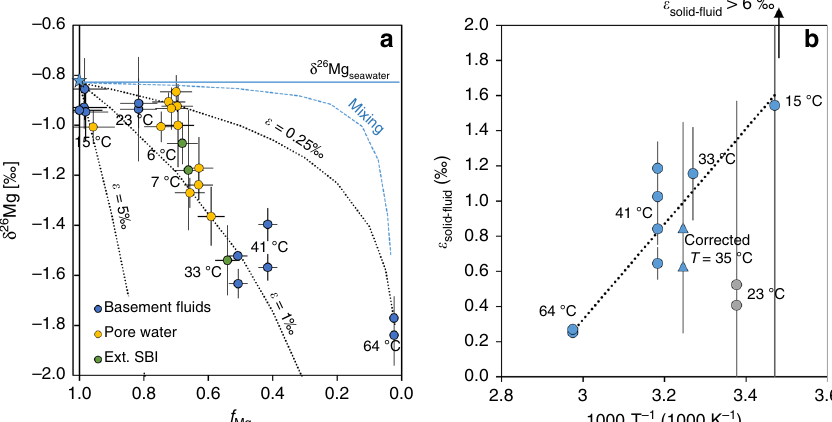
Fig. 3 Mg isotopes in the low-temperature hydrothermal (LTH) system. a δ 26 Mg values of LTH fl uids vs. the remaining fraction of Mg relative to bottom seawater, f Mg (Table 1). Types of fl uids are indicated by blue (basement fl uids), yellow (sediments pore water), and green (extrapolated sediment- basement interface, Ext. SBI) circles. The pore-water sample from Site 1363G (see Supplementary Table 1) was collected right at the SBI and it is thus shown in green. Labels indicate the SBI temperature at each site. Blue-dashed line shows the trajectory expected for mixing between seawater and the warmest LTH endmember. Black-dotted lines show theoretical Rayleigh fractionation curves (see Methods) using different enrichment factors ( ε solid- fl uid ). Modern seawater is indicated by a blue star and, for convenience, its δ 26 Mg value is shown by a blue solid line. Error bars are 2 SD. b The isotope fractionation, ε solid- fl uid , vs. 1000T − 1 , where T is the temperature at SBI in K (see also Table 1). Temperatures in °C are shown as labels. Two extremely high ε solid- fl uid are not shown (arrow). Triangles indicate that the SBI temperature was corrected to 35 °C, as suggested by the Mg concentrations (Holes 1363F and 1363G). Gray circles are the samples from Site 1024, which were excluded from the regression line. Analytical errors (2 SD) on the x-axis are within symbols. Error bars on y-axis are propagated 2 SD errors (Table 1). The black-dotted line is a linear regression through all data weighted by the error of each data point.